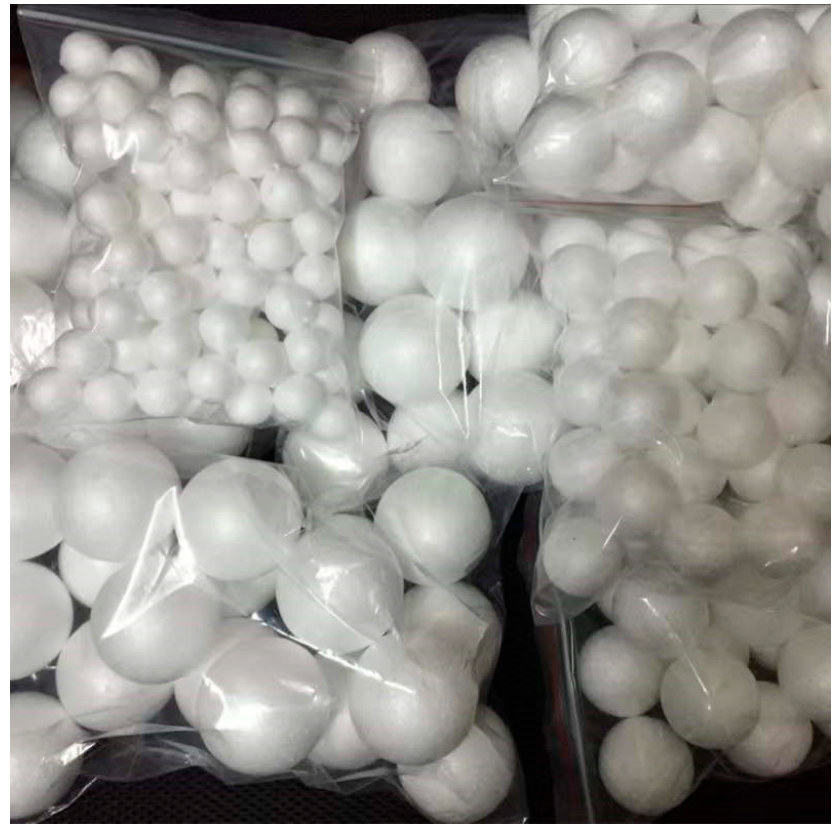
Figure 2. The EPS float balls used in